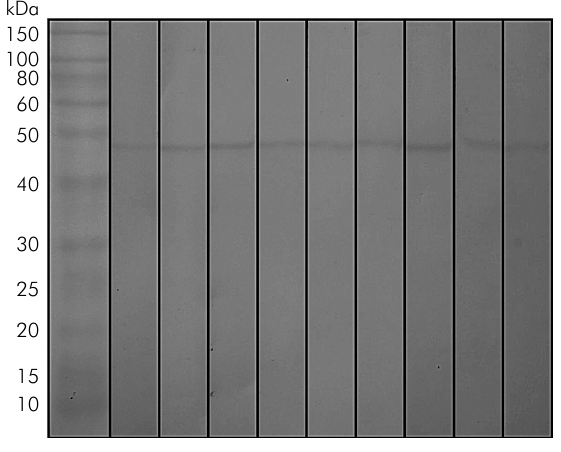
Figure 5. Western blot analysis of saliva samples. Recognition pattern of anti-HDE SIgA in saliva of traumatized and non-traumatized patients. The first column presents molecular weights. Blots 1 to 5 were saliva samples of traumatized patients and blots 6 to 9, of non-traumatized patients.